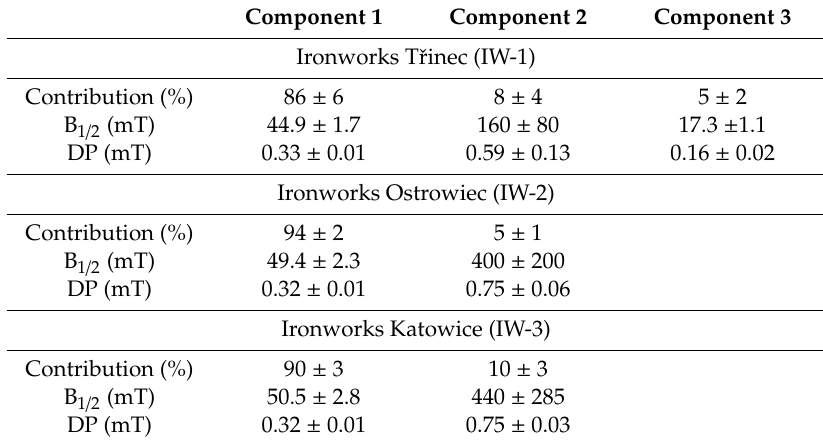
Table 2. Average values of percentage contribution, mean coercivity (B 1 / 2 ) at which half of the saturation isothermal remanent magnetization is reached, and dispersion parameter (DP) for the components of isothermal remanent magnetization acquisition curves measured for the topsoil